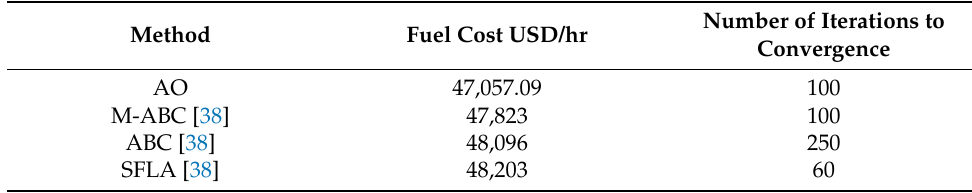
Table 5. Result comparison for OPF IEEE-118 bus system.